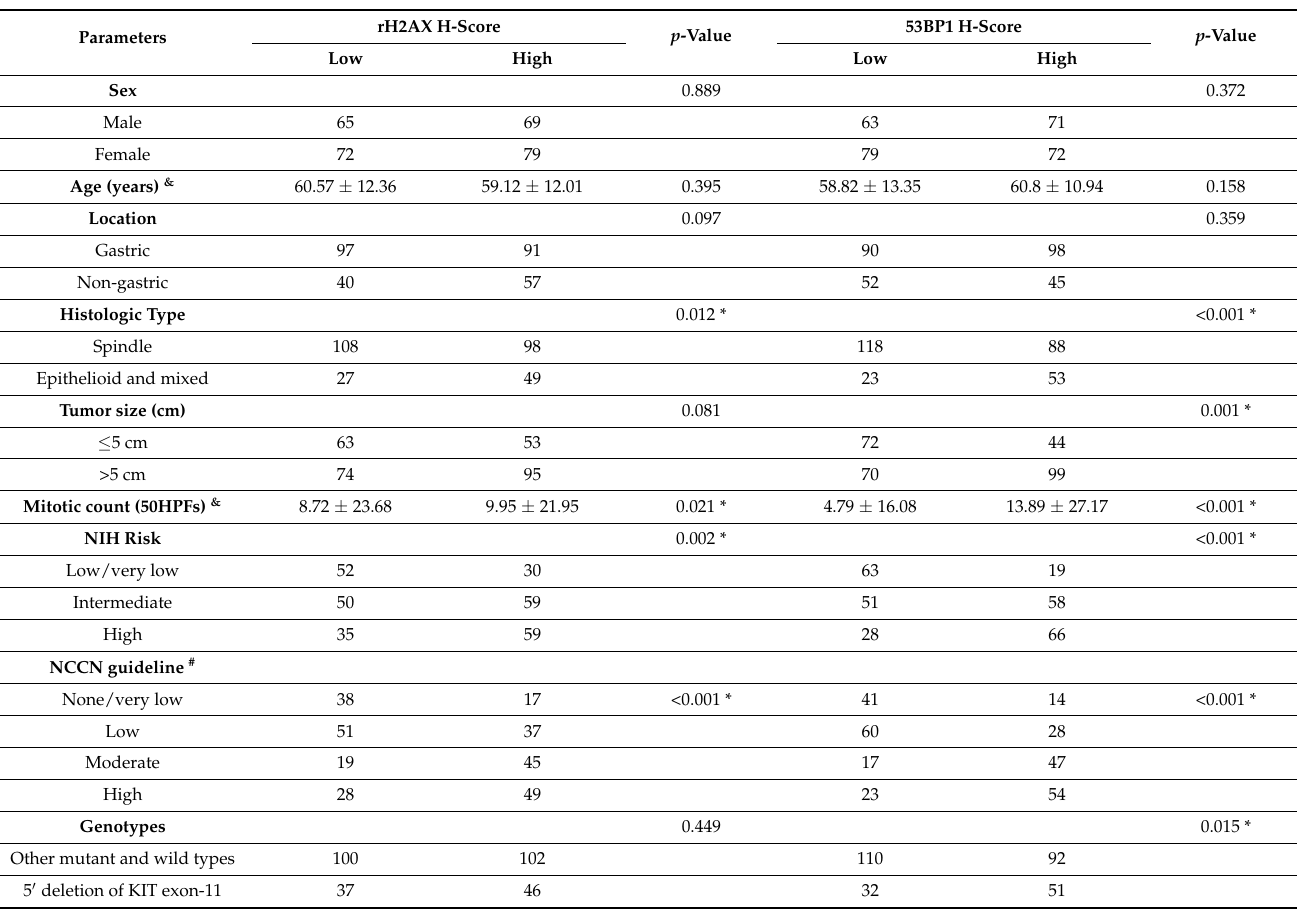
Table 3. Immunohistochemistry of rH2AX and 53BP1 in the tissue microarray-based cohort: associa- tions of expression levels with clinicopathologic and mutation